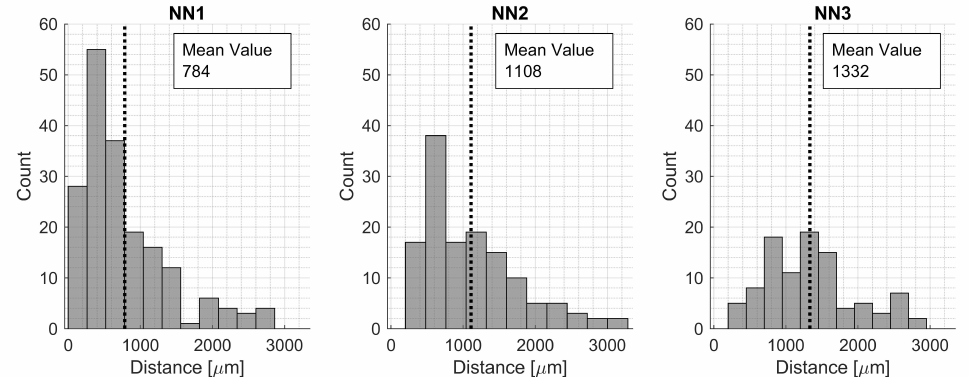
Figure 8. Presenting the first, second, and third NN distances between voids for the manufac- tured